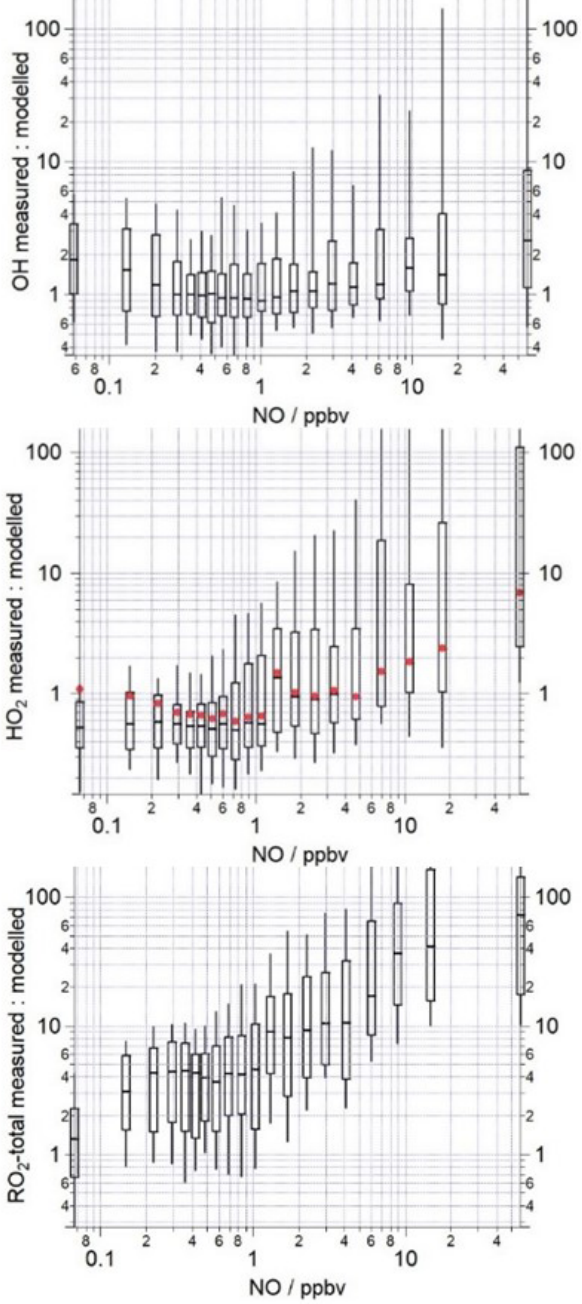
Figure 6. The median ratio ( − ) of the measured to modelled OH, HO 2 and total RO 2 binned over the NO mixing ratio range encoun- tered during the campaign on a logarithmic scale. The box and whiskers represent the 25th and 75th and the 5th and 95th con- fidence intervals. The red circles in the middle panel display the measured to modelled HO 2 ratio when the model includes a het- erogeneous loss of HO 2 to aerosols calculated using Eq. (9). The number of data points in each of the NO bins is ≈